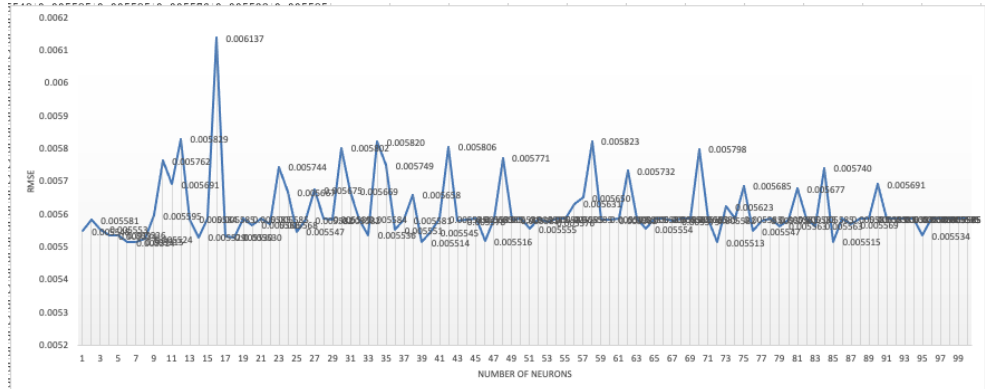
Figure 3. RMSE of ARMA-CNNLSTM forecasts using different model parameters in the validation set of Shanghai stock index forecasting.